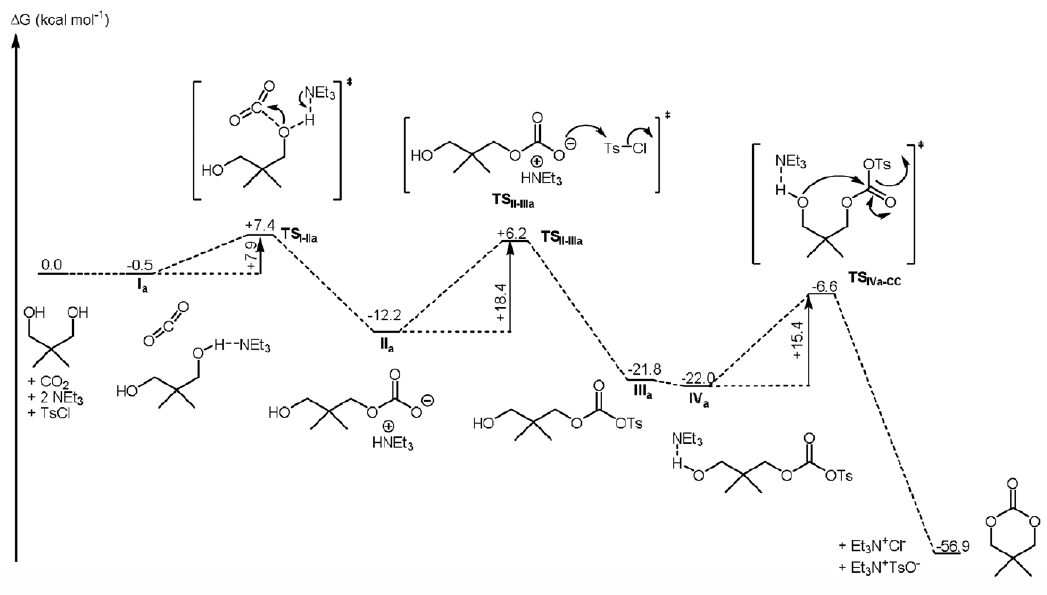
Figure 3. DFT computed free enthalpy diagram for the direct coupling of CO 2 with 2,2-dimethyl- 1,3-propanediol using 2 equiv. of NEt 3 and 1 equiv. of TsCl (pathway of less energy). Reproduced